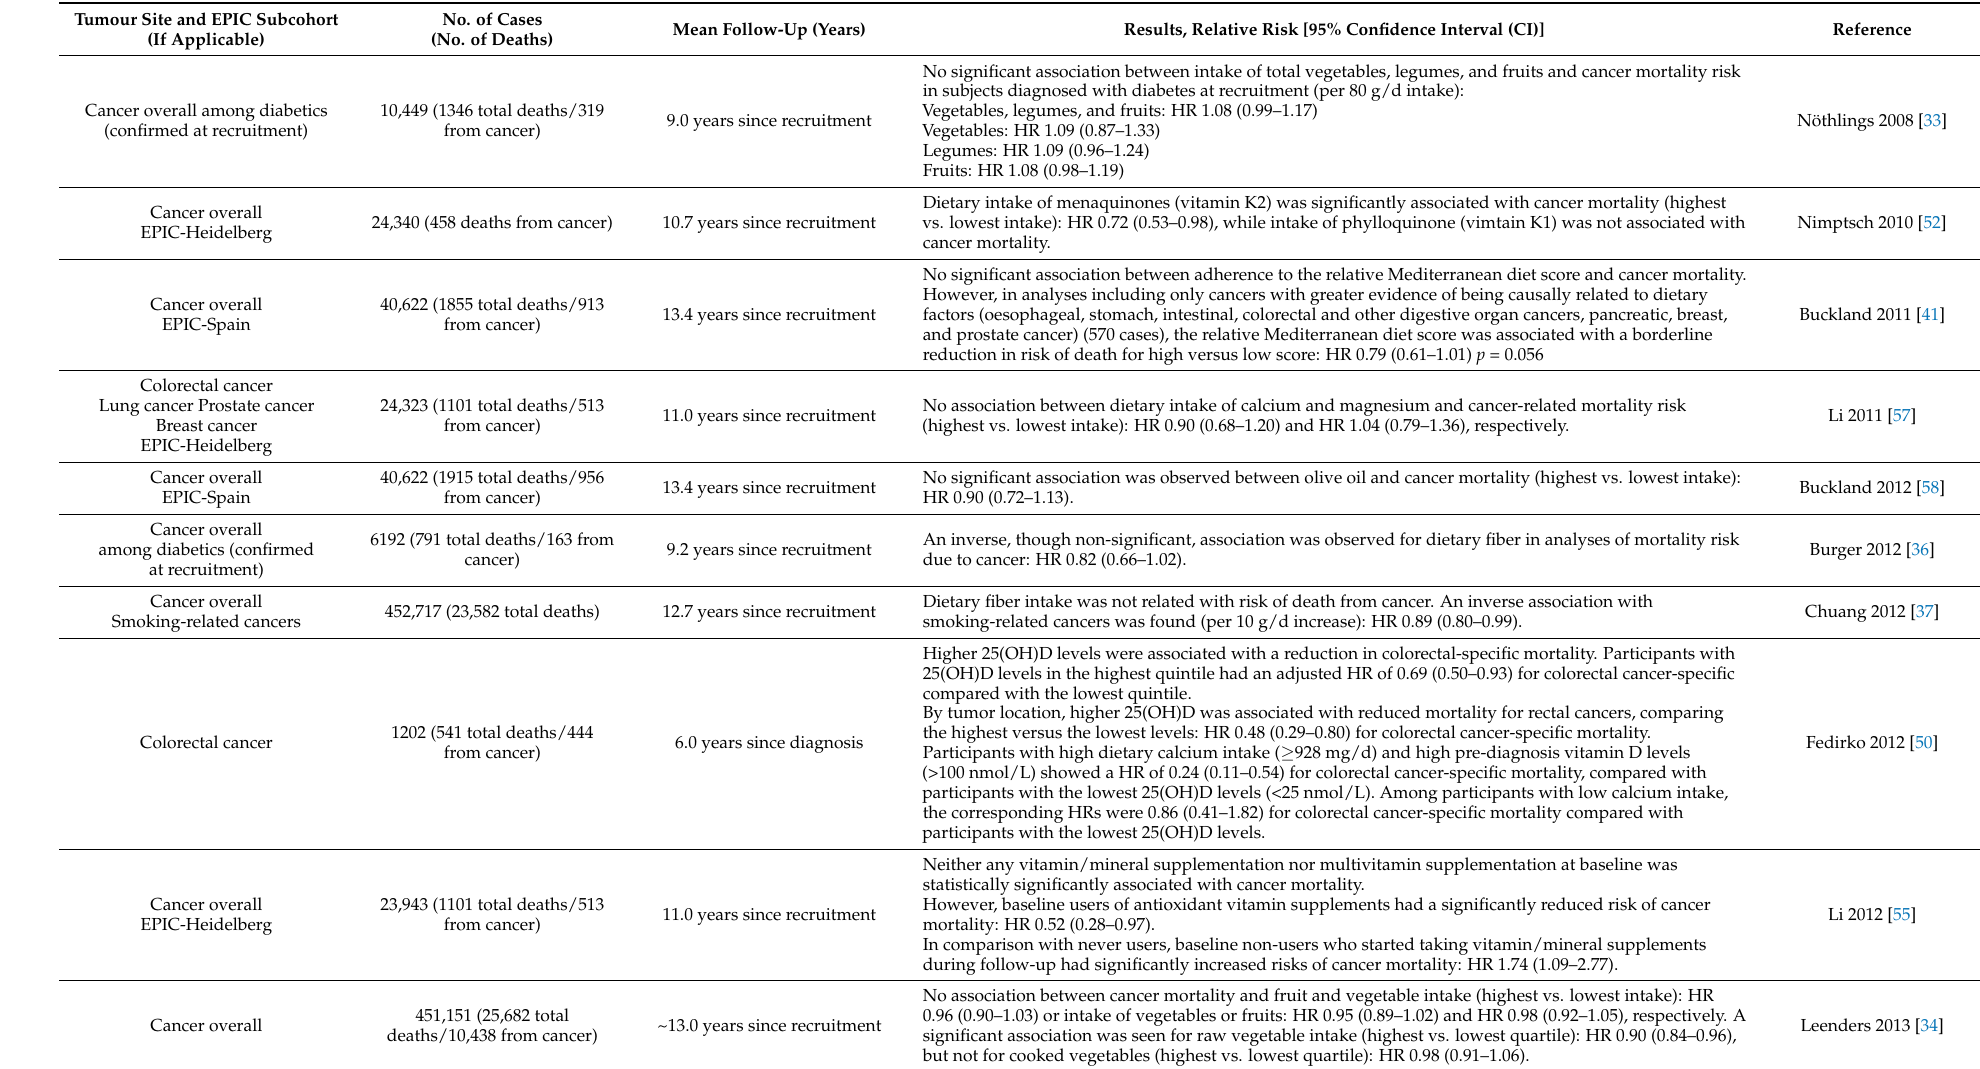
Table 1. Dietary factors investigated as potential protective factors in relation to cancer mortality in the EPIC